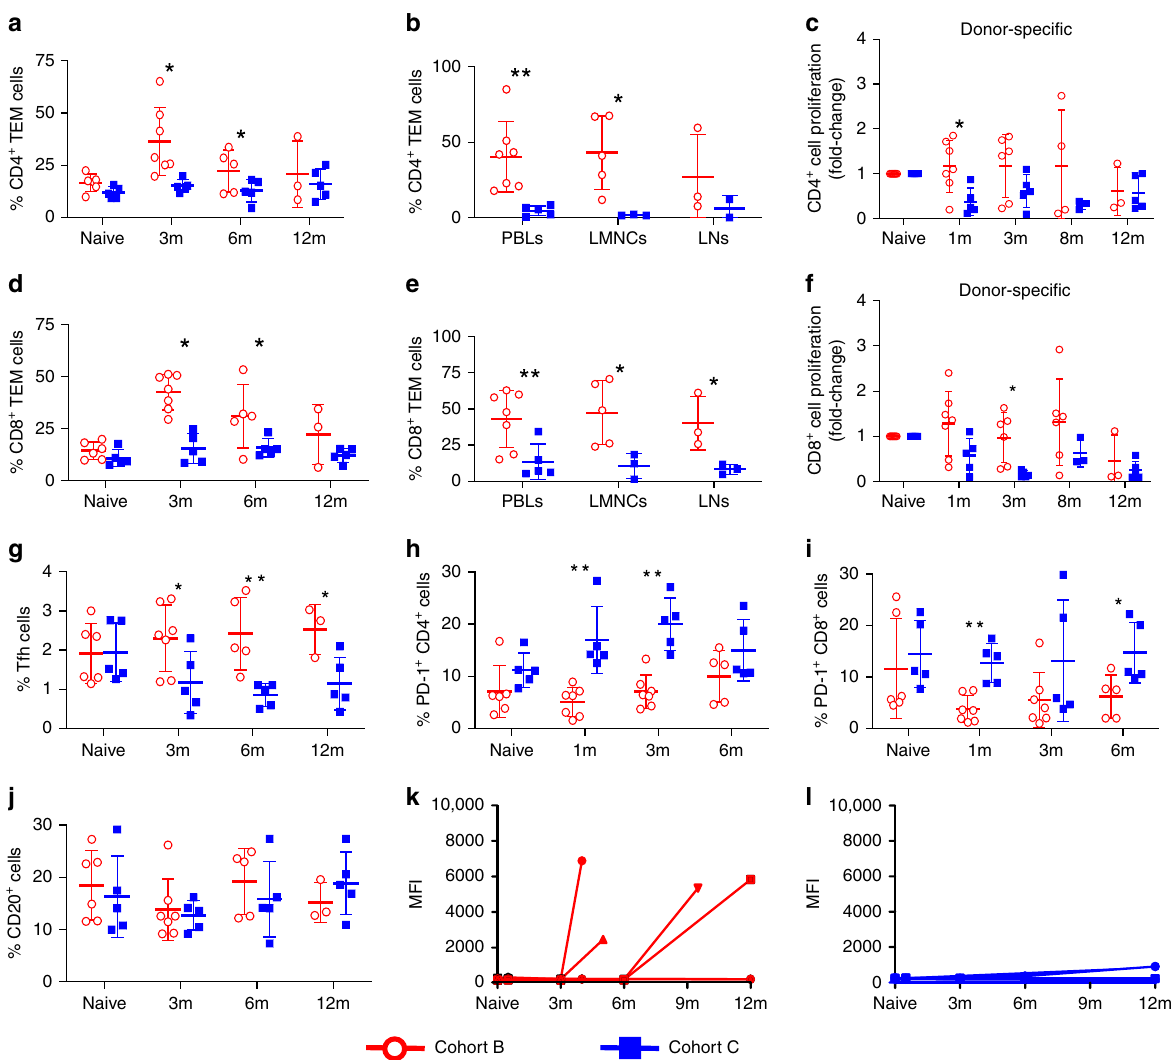
Fig. 3 Apoptotic donor leukocyte infusions suppress effector cell expansion and function. a Percentage of CD4 + T effector memory (TEM) cells in the peripheral blood lymphocytes (PBLs) measured longitudinally before and at 3, 6, and 12 months posttransplant in recipients from Cohorts B ( n = 7; red) and C ( n = 5; blue); see also Supplementary Fig. 7a, b. b Percentage of CD4 + TEM cells in PBLs, liver mononuclear cells (LMNCs), and lymph nodes (LNs) at termination in recipients from Cohorts B ( n = 3 – 7, red) and C ( n = 2 – 5, blue). c Fold change in proliferation (compared to pretransplant levels;